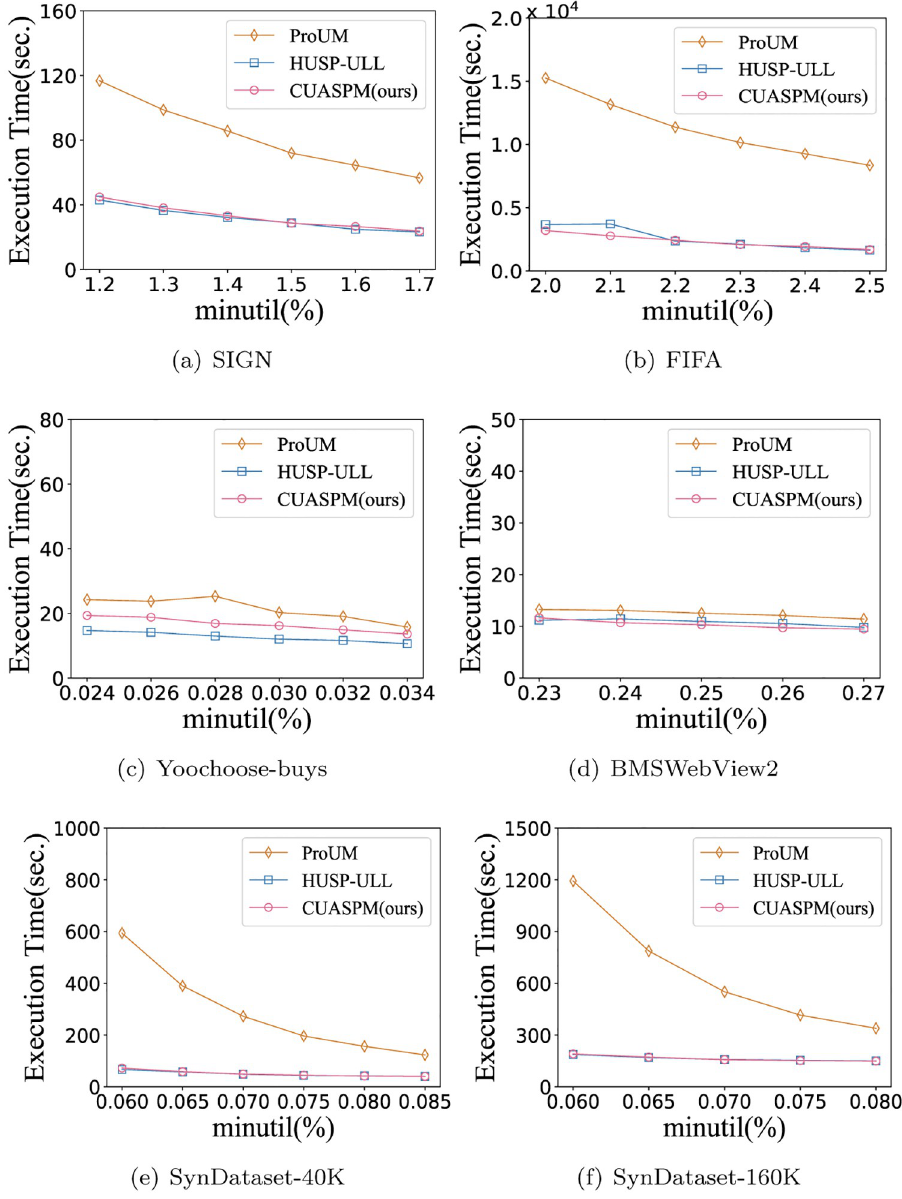
Fig 4. Execution time under the various minutil thresholds. (a) SIGN, (b) FIFA, (c) Yoochoose-buys, (d) BMSWebView2, (e) SynDataset-40K, and (f)